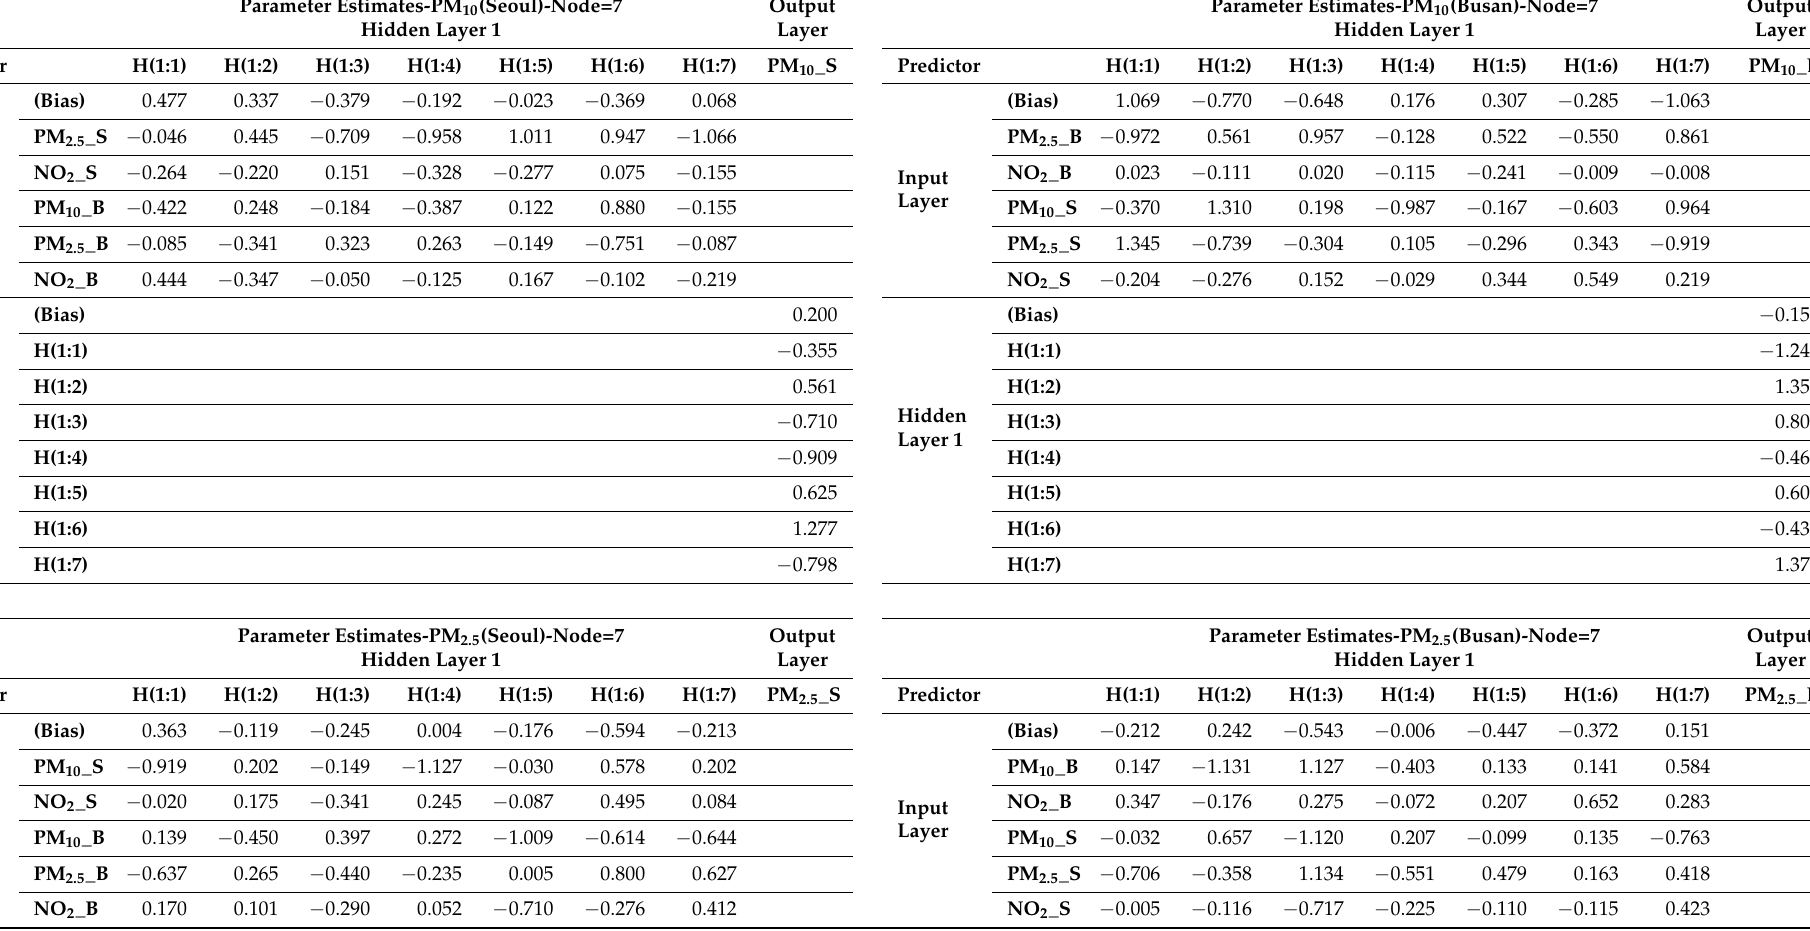
Table 3. As shown in Table 1, except for 7 nodes in a single hidden layer in Seoul and Busan cities. Parameter Estimates-PM 10